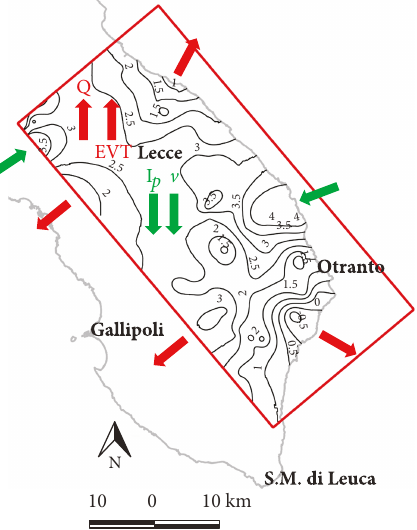
Figure 4: Hydrodynamics of the deep aquifer. Contour lines were obtained by interpolation of the available head data (values in m above msl; contour line interval: 0.5m). Arrows indicate in fl ow (green arrows) and out fl ow (red arrows) to the aquifer across the boundary of the study area and due to sink and source terms.